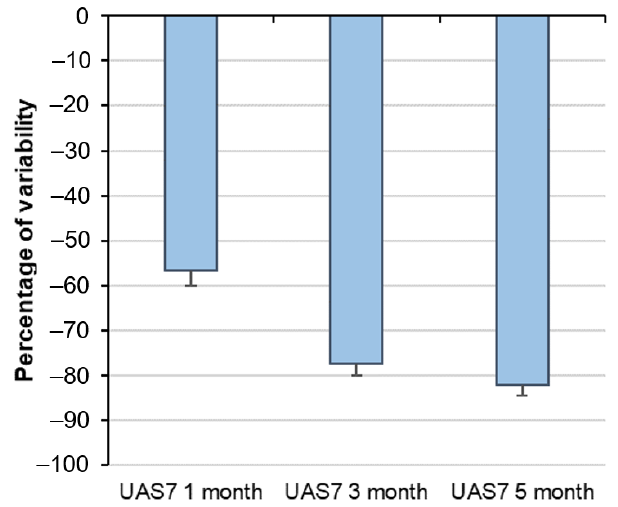
Figure 1. Variability of the response to Omalizumab over 5 months treatment.